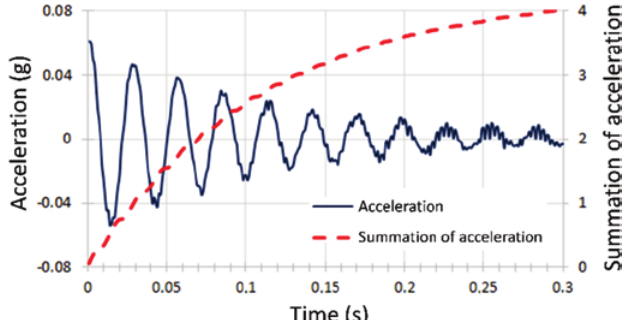
Figure 7 Acceleration graph over time and curve of the sum of the accelerations